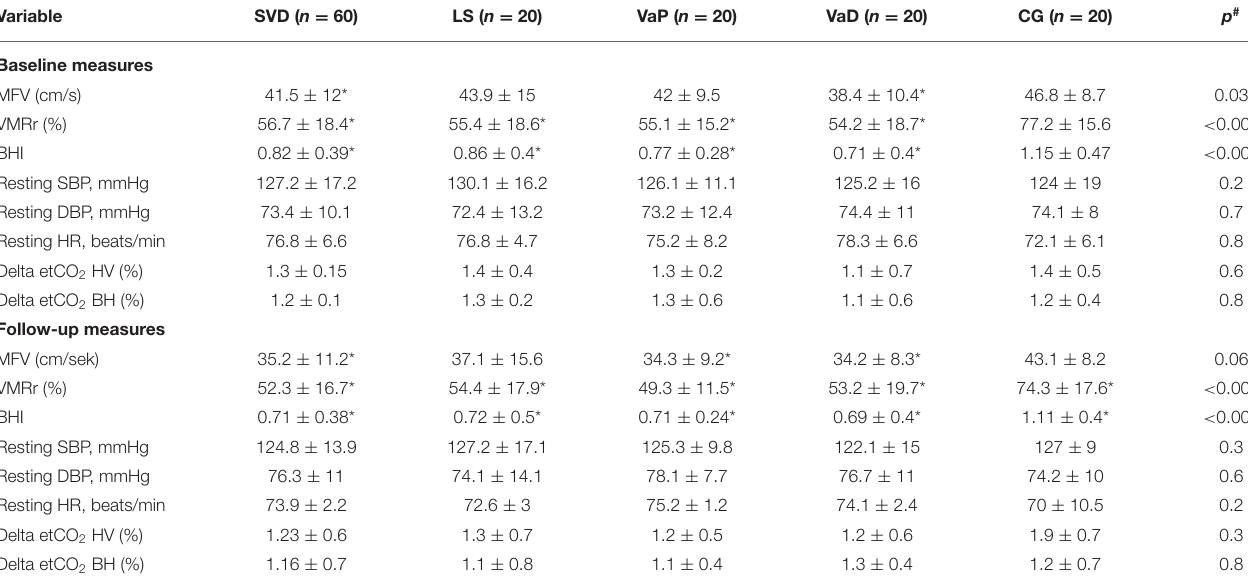
TABLE 2 | Basal and follow-up characteristics and vasodilatation responses of cerebral arteries in all the subjects.